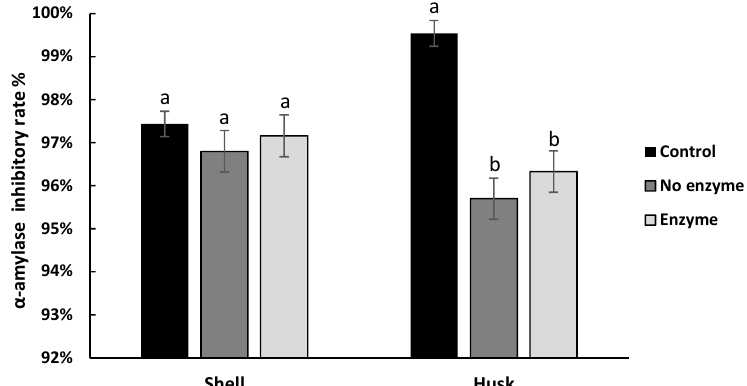
Figure 4. The inhibitory rate of walnut pigment from brown shell and green husk on α -amylase activity with / without enzyme digestion. The data presented in this table consist of average quantities ± SD of three independent samples. Di ff erent letters (a–c) in the bars within each group represent statistically significant di ff erences ( p < 0.05).